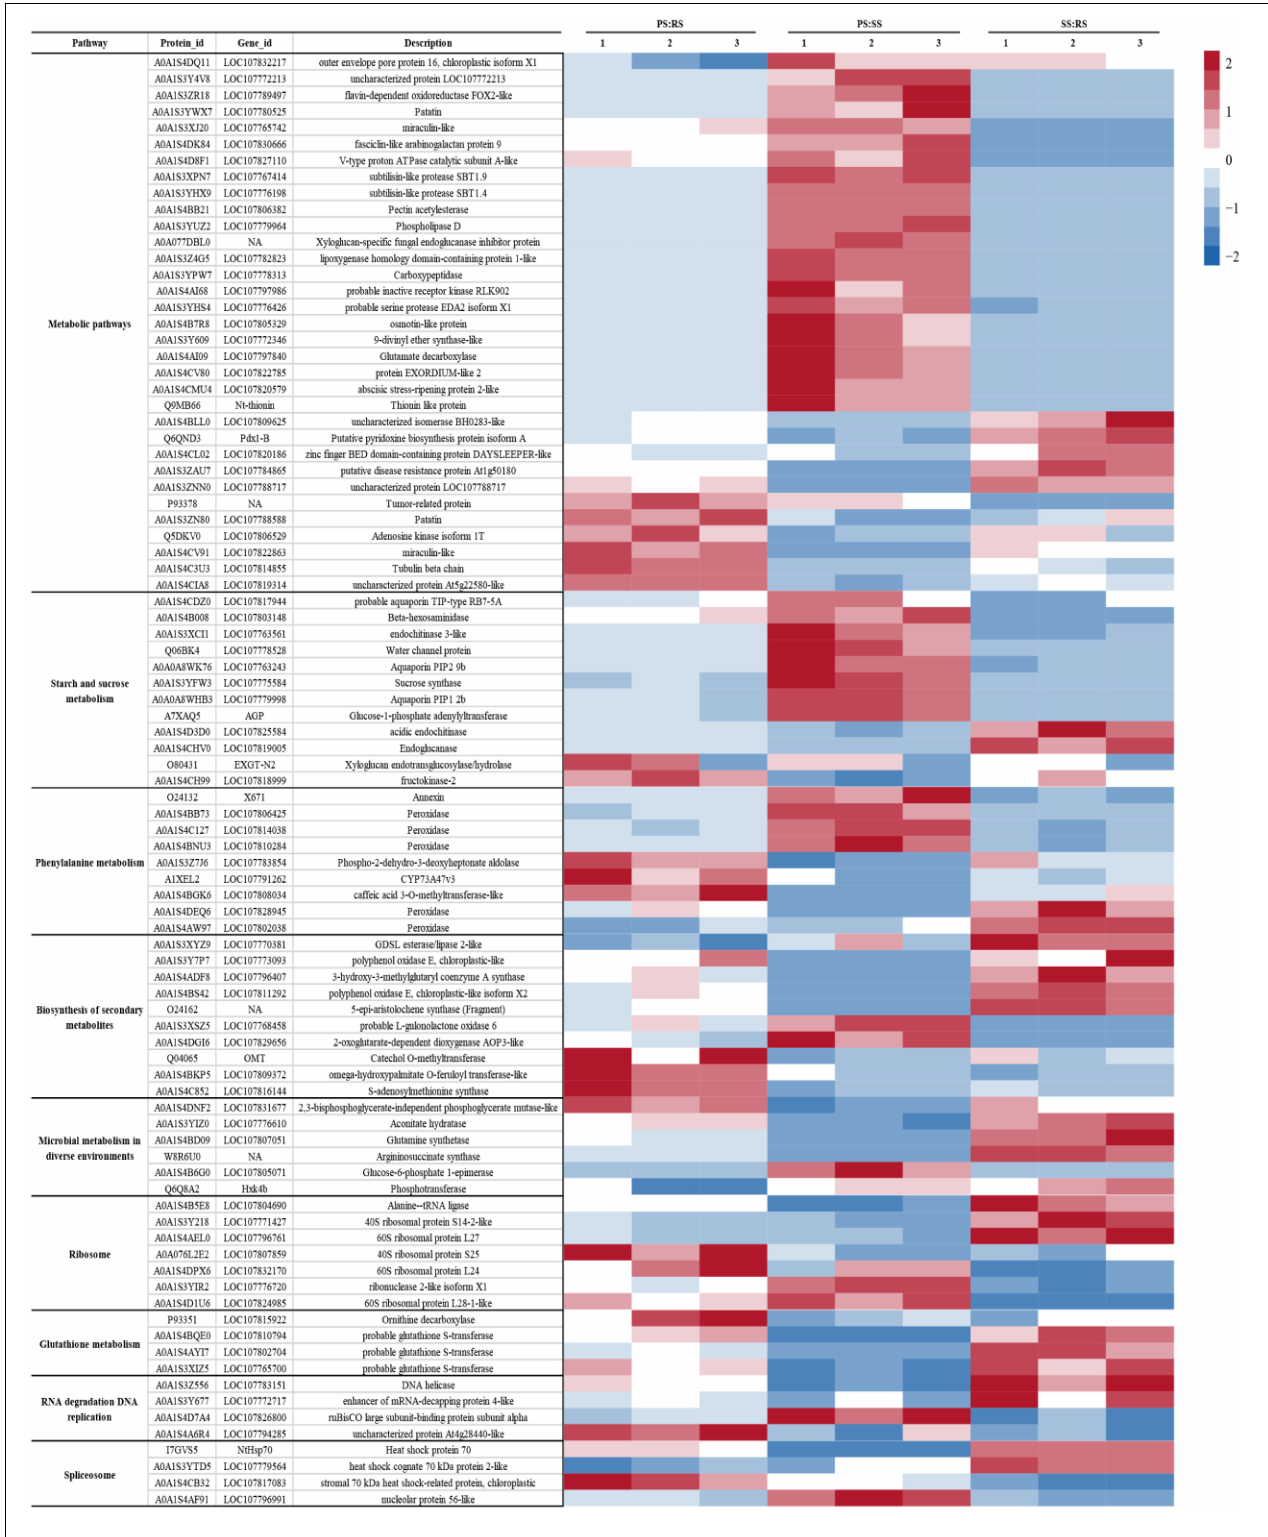
FIGURE 6 | Differential protein relative expression matrix heatmap of the three groups. The color in the figure indicates the relative protein abundance level of the protein in the sample. The red color indicates that the protein has an increased protein abundance level in the sample, and the blue color represents a decreased protein abundance